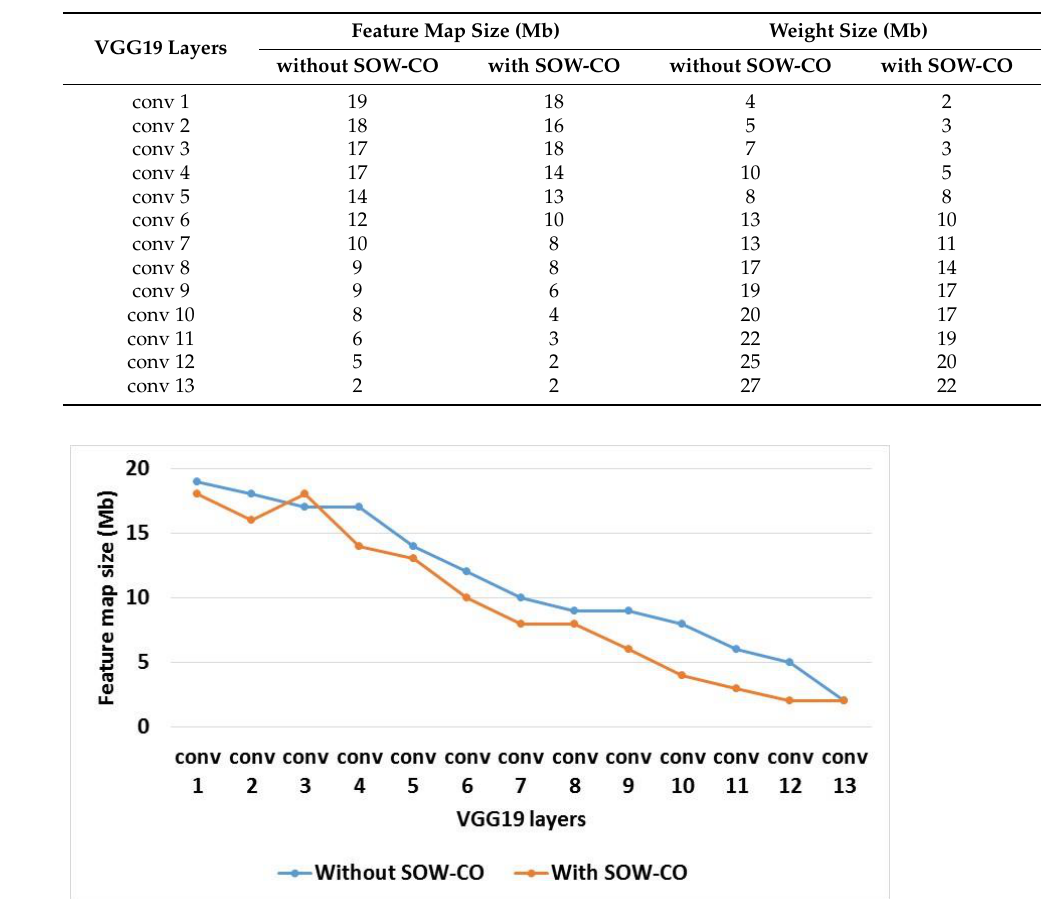
Figure 14. Graphical illustration of weight size for VGG19. An evaluation of sparseness of the IFM and weight parameter proportion for RCNN- Alexnet with and without SOW-CO is shown in Table 5. The graphical illustrations of the IFM’s sparsenes s and weight parameter proportion for RCNN-Alexnet are shown in Fig- ures 15 and 16, respectively. This analysis shows that the IFM’s sparseness and weight parameter proportion of RCNN-Alexnet with SOW-CO are less when compared to the RCNN-Alexnet without SOW-CO. The optimization of weight using the sparsity is used to optimize the IFM’s sparseness and weight parameter.